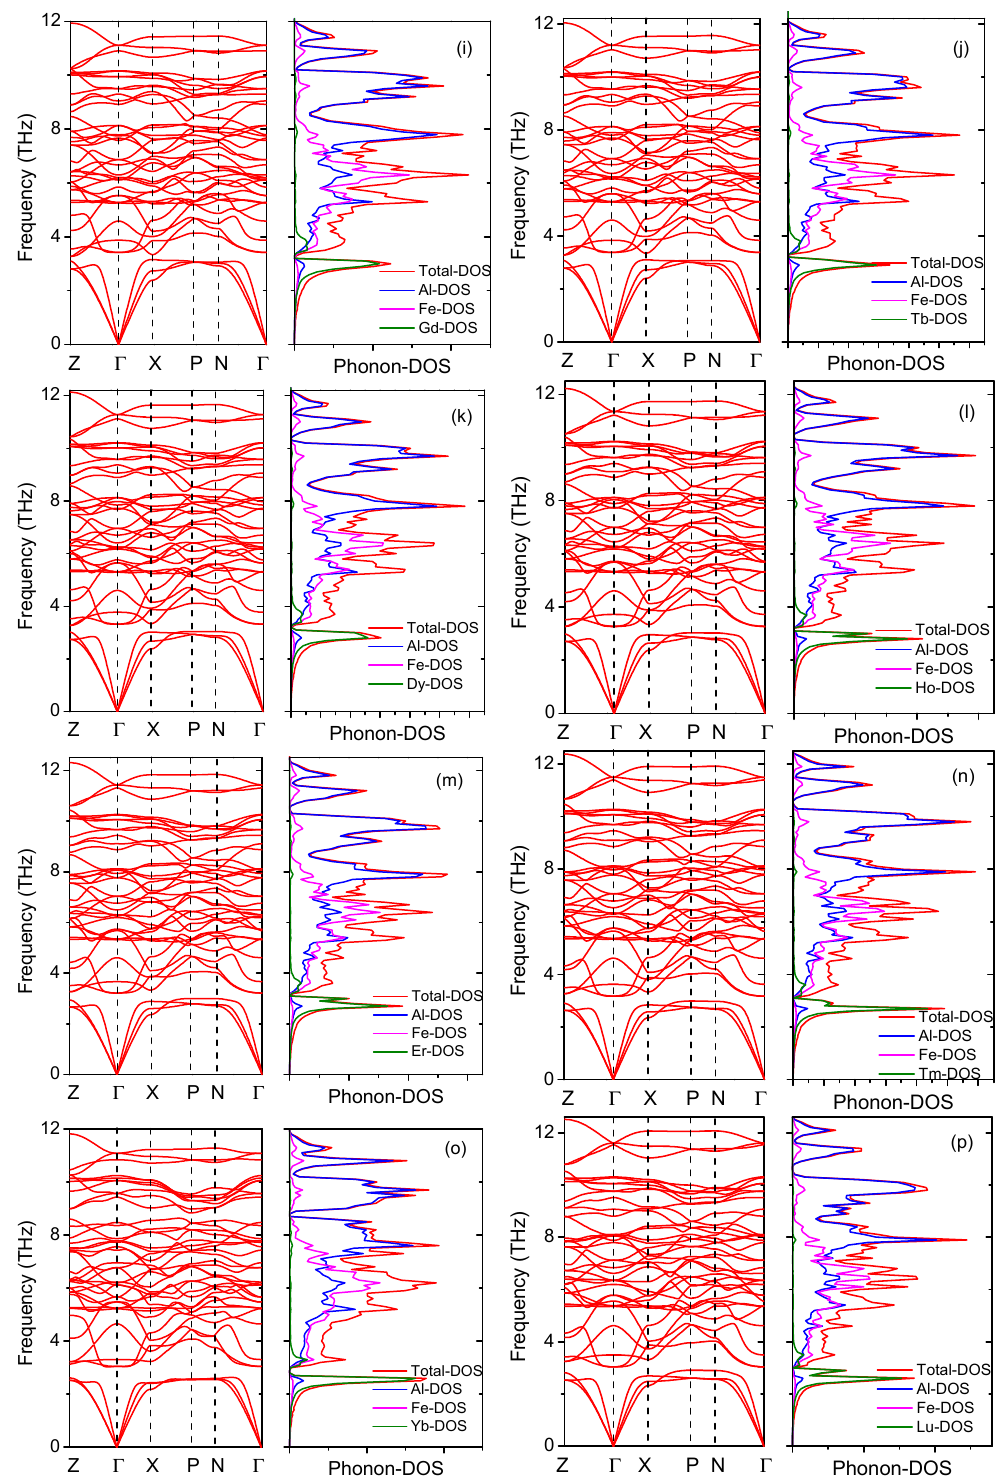
Figure 4. Phonon dispersion spectrum and phonon density of state for Al 8 Fe 4 RE(RE = Sc, La–Lu) IMCs. ( a ) Al 8 Fe 4 Sc; ( b ) Al 8 Fe 4 La; ( c ) Al 8 Fe 4 Ce; ( d ) Al 8 Fe 4 Pr; ( e ) Al 8 Fe 4 Nd; ( f ) Al 8 Fe 4 Pm; ( g ) Al 8 Fe 4 Sm; ( h ) Al 8 Fe 4 Eu; ( i ) Al 8 Fe 4 Gd; ( j ) Al 8 Fe 4 Tb; ( k ) Al 8 Fe 4 Dy; ( l ) Al 8 Fe 4 Ho; ( m ) Al 8 Fe 4 Er; ( n ) Al 8 Fe 4 Tm; ( o ) Al 8 Fe 4 Yb; ( p ) Al 8 Fe 4